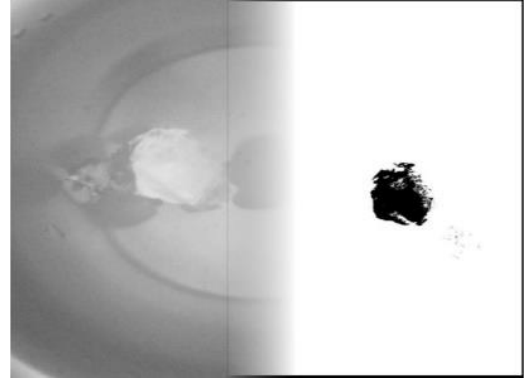
Figure 4. Image pre-processing — binarisation.